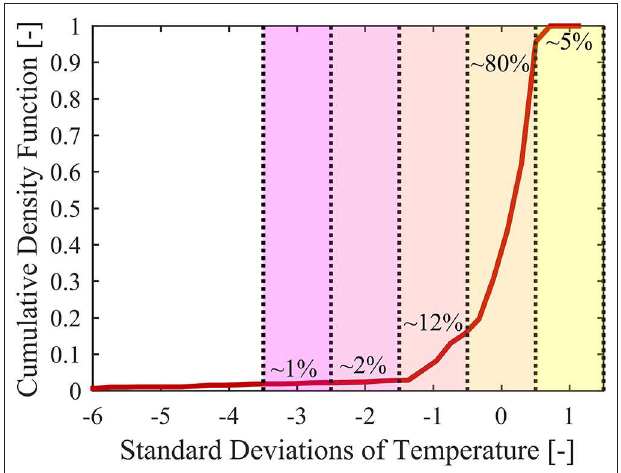
FIGURE 4 | Cumulative density function of temperature normalized by standard deviation (red line), showing the relative distribution of temperature among “thermal zones” denoted by